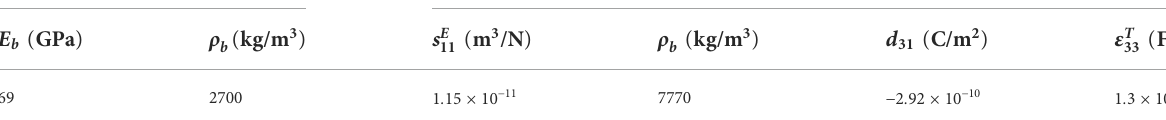
TABLE 2 Material parameters.